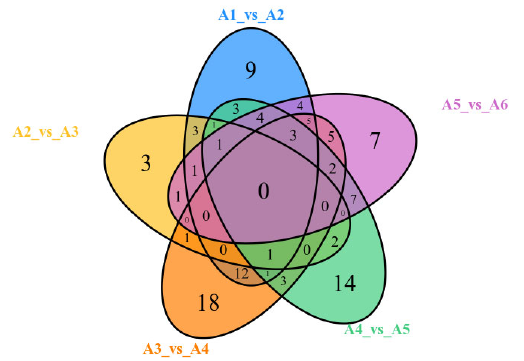
Figure 8. Wayne diagram of flavonoid differential metabolites in each comparison group.